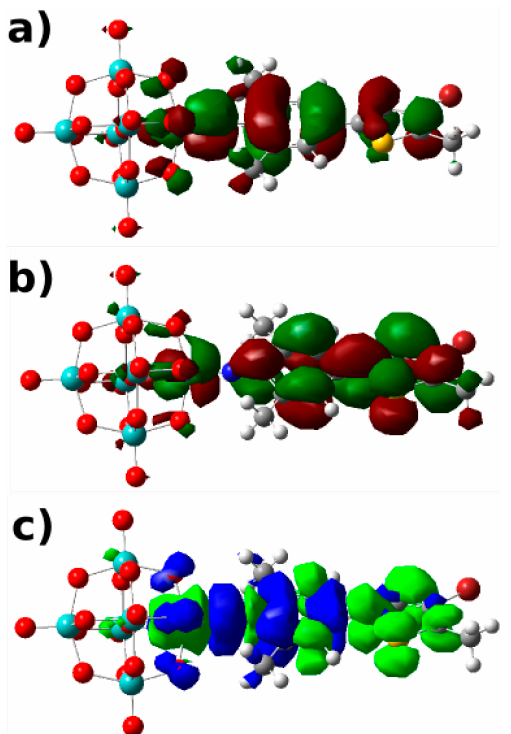
Figure A9. ( a ) Highest occupied molecular orbital obtained at the CAMB3LYP/def2-TZVPP level of theory displayed with an isovalue of 0.02 e − /Å 33 . ( b ) Lowest unoccupied molecular orbital obtained at the CAMB3LYP/def2-TZVPP level of theory displayed with an isovalue of 0.02 e − /Å 33 . ( c ) Difference density for the CT transition obtained at the TDA-CAMB3LYP/def2-TZVPP level of theory displayed with an isovalue of 0.0004 e − /Å 33 . Green lobes indicate an increase in electron density upon electronic excitation and blue indicates a decrease. All surface plots were generated with Gaussview 5.0 [34].